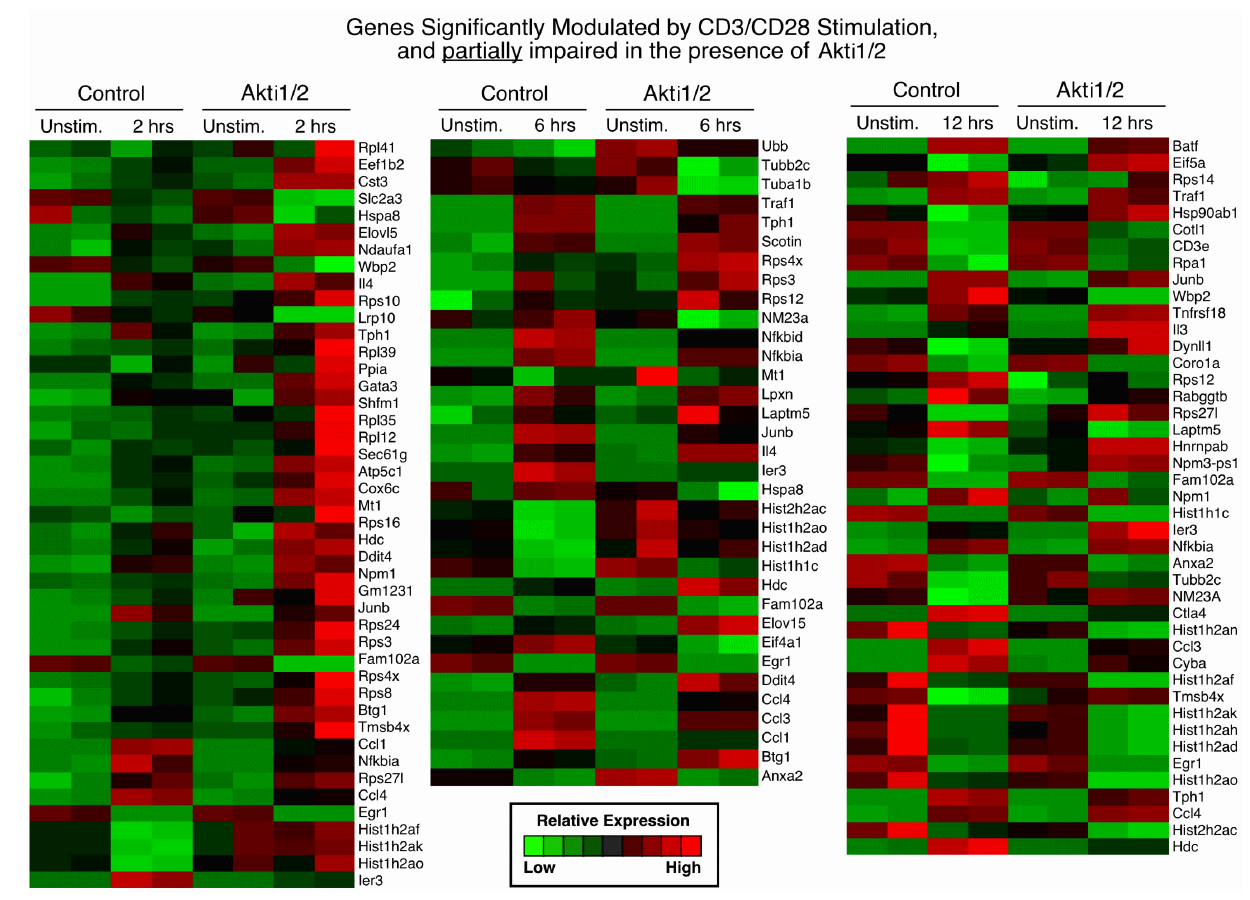
Supplementary Figure 2. Genes significantly modulated by CD3/CD28 stimulation alone but less modulated in the presence of Akti1/2. Each row represents a gene and each column shows one of the duplicates from two different groups (from left to right 0 h vs. 2 h, 0 h vs. 6 h, 0 h vs. 12 h). The red and green colors reflect high and low expression levels, respectively.